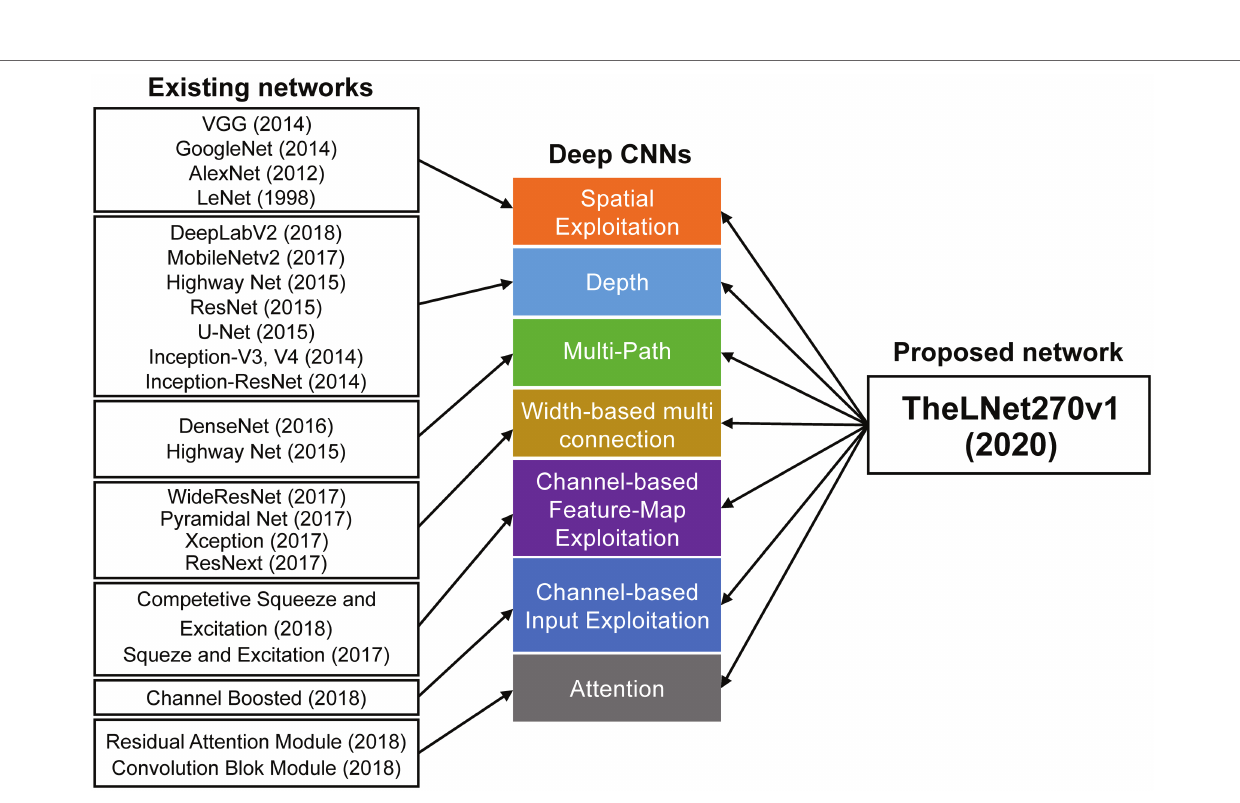
FIGURE 2 | Classification of available and proposed deep network